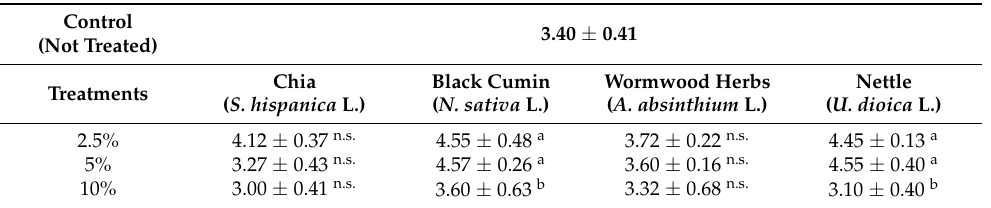
Table 9. Comparison of differences of means for hypocotyl length of spinach ( S. oleracea L.) seedlings (The values in the table represent the mean value of hypocotyl length in cm ± SD).